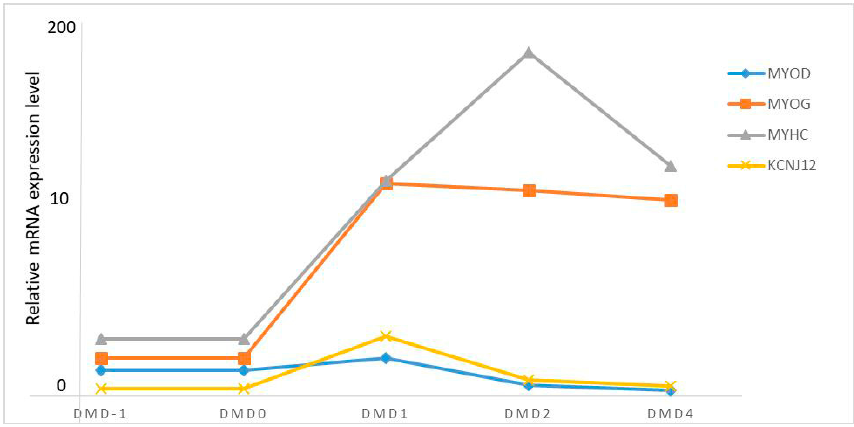
Figure 5. Expression of KCNJ12 , MYOD , MYOG, and MYHC genes during myoblast differentiation. Relative mRNA expression levels of KCNJ12 , MYOD , MYOG , and MYHC genes in different differentiation periods were analyzed by qPCR in primary bovine skeletal muscle cells. The mRNA expression levels of the four genes were normalized to GAPDH . The values 0–10 have the same unit as 10–200 on the Y-axis. DMD − 1: differentiating myoblast day − 1; DMD0: differentiating myoblast day 0; DMD1: differentiating myoblast day 1; DMD2: differentiating myoblast day 2; DMD4: differentiating myoblast day 4.